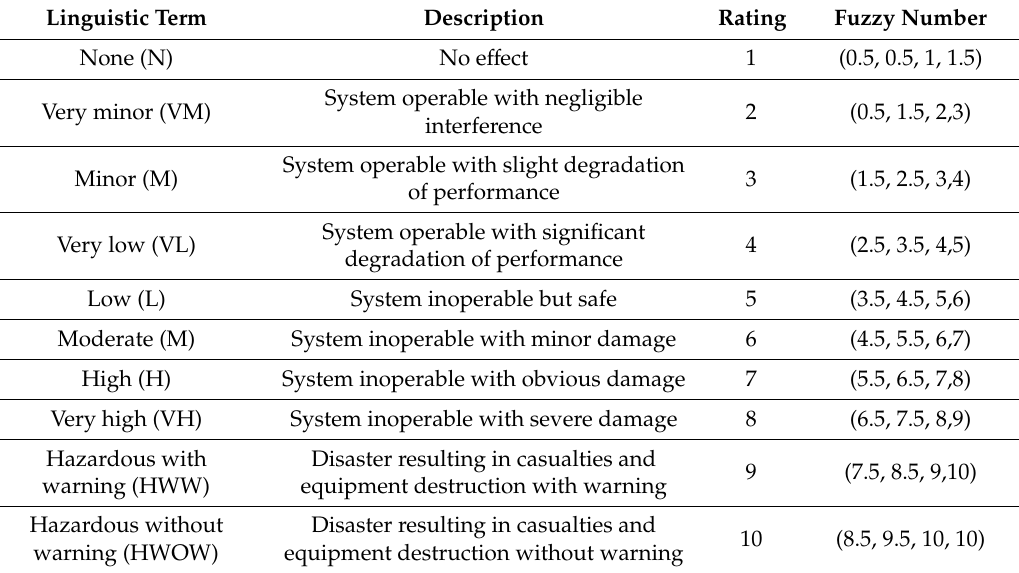
Table 1. Fuzzy evaluation criteria of severity.